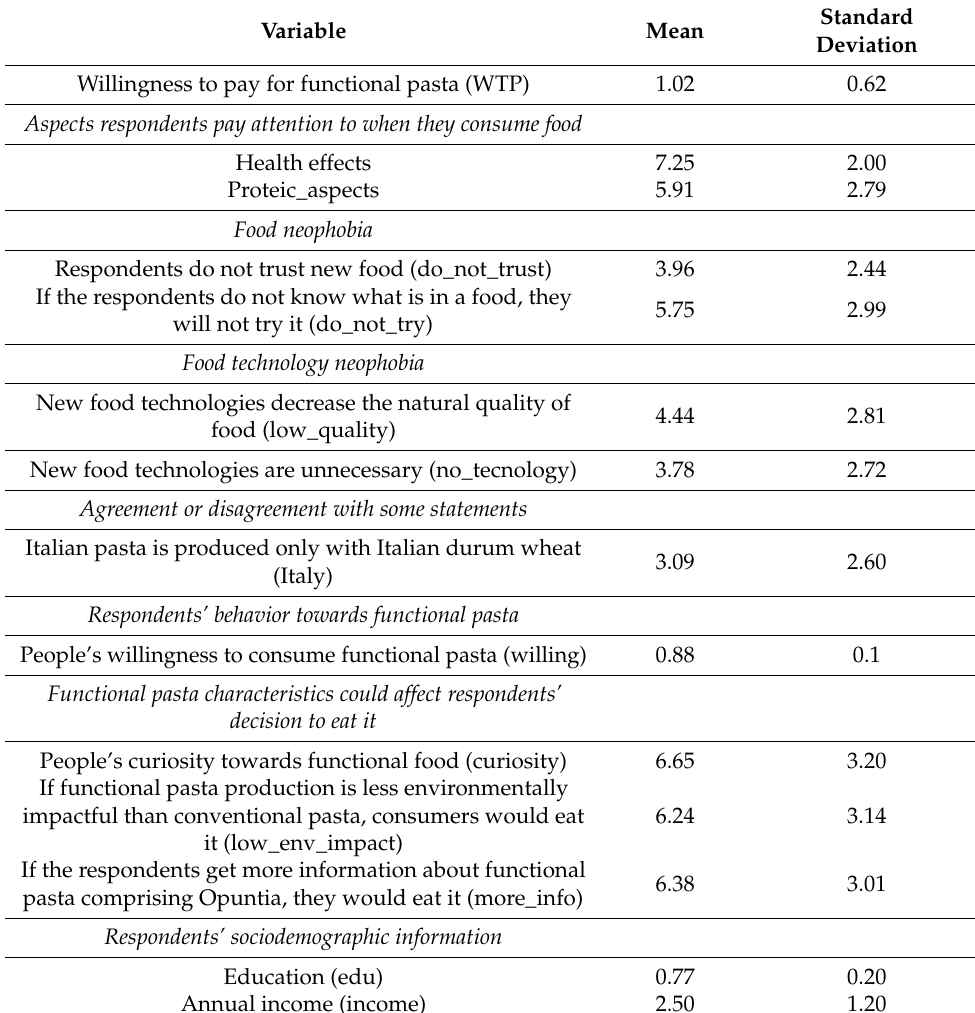
Table 2. Variables used in the